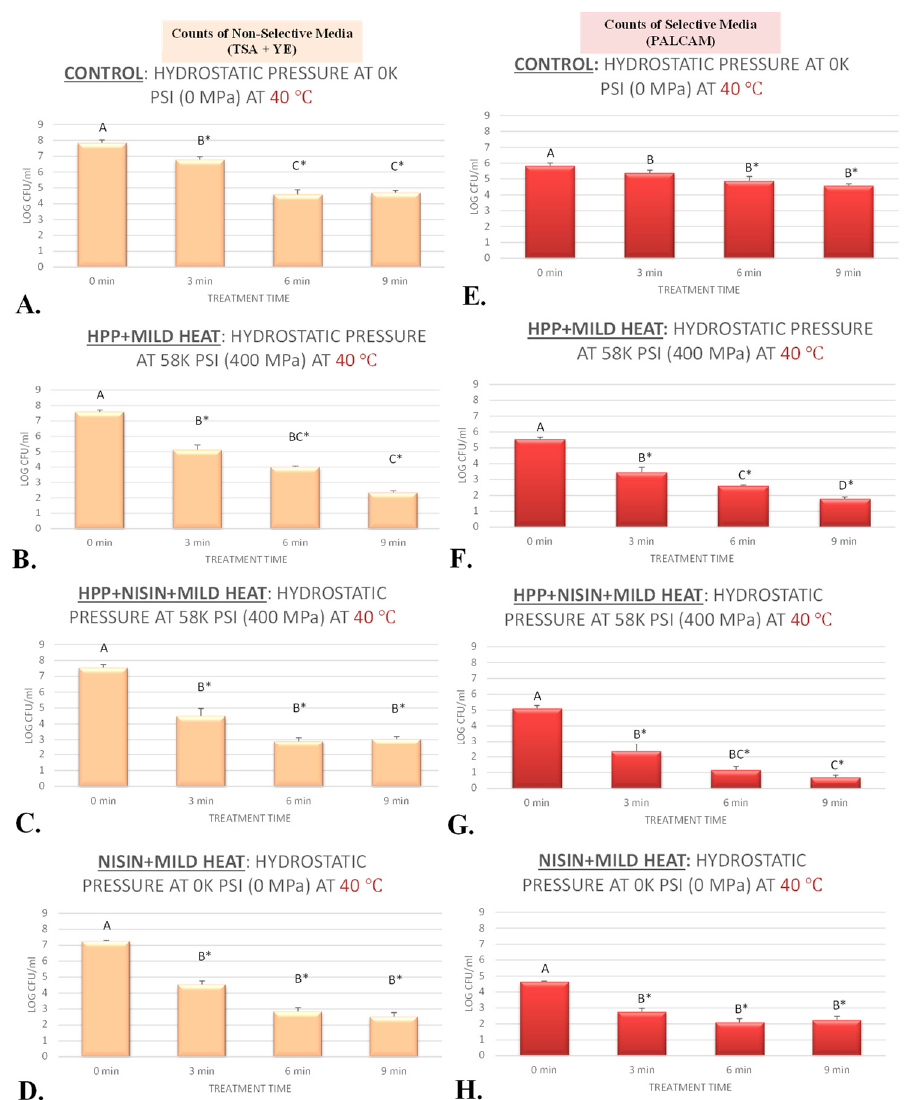
Figure 2. Inactivation of four-strain cocktail of L. monocytogenes (ATCC @ 51772, 51779, BAA-2657, and 13932) in sterilized phosphate-buffered saline, treated by nisin (5000 IU/mL) and elevated hydrostatic pressure at 400 MPa (Barocycler Hub880 Explore, Pressure Bioscience Inc., Easton, MA, USA) for 0, 3, 6, and 9 min at 40 °C. In each graph and for each microbiological medium (PALCAM (selective counts), TSA + YE (non-selective counts)) separately, columns of each time interval followed by different uppercase letters are representing log CFU/mL values (Mean ± SD) that are statistically ( p ˂ 0.05) different (Tukey-adjusted ANOVA). Uppercase letters followed by * sign are statistically ( p ˂ 0.05) different than untreated control (not treated with the antimicrobial) (Dunnett’s-adjusted ANOVA). ( A ) Nonselective counts (TSA + YE), treated by heat at 40 °C; ( B ) Nonselective counts (TSA + YE), treated by hydrostatic pressure at 400 MPa (58 K PSI) and at 40 °C; ( C ) Nonselective counts (TSA + YE), treated by hydrostatic pressure at 400 MPa (58 K PSI) and exposed to nisin (5000 IU/mL) at 40 °C; ( D ) Nonselective counts (TSA + YE), exposed to nisin (5000 IU/mL) at 40 °C. ( E ) Selective counts (PALCAM), treated by heat at 40 °C; ( F ) Selective counts (PALCAM), treated by hydrostatic pressure at 400 MPa (58 K PSI) and at 40 °C; ( G ) Selective counts (PALCAM), treated by hydrostatic pressure at 400 MPa (58 K PSI) and exposed to nisin (5000 IU/mL) at 40 °C; ( H ) Selective counts (PALCAM), exposed to nisin (5000 IU/mL) at 40 °C.